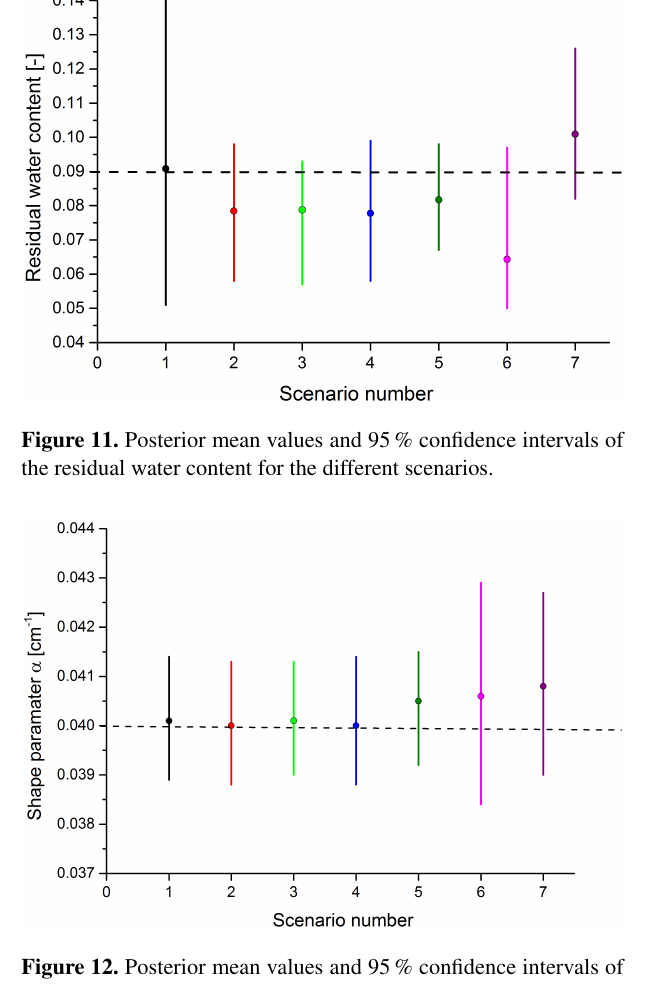
Figure 14. Posterior mean values and 95% confidence intervals of dispersivity for the different